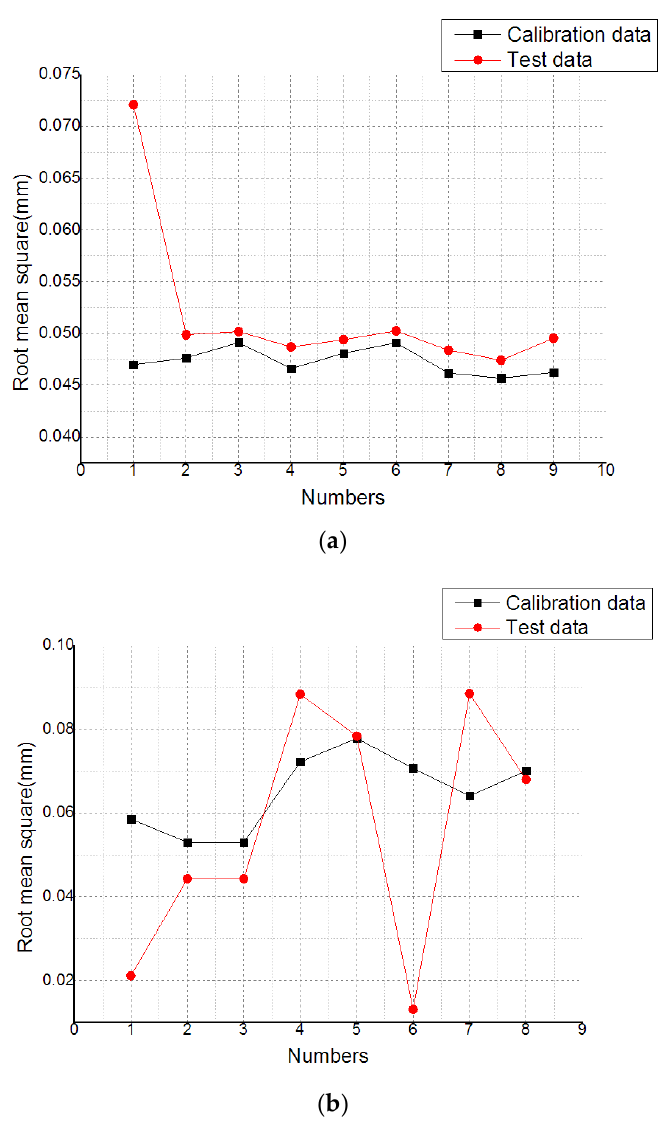
Figure 8. Analysis of different radial basis function interpolation and fitting accuracy with different shape parameters. ( a ) is the root mean square (RMS) calculated by using different shape parameters with different Multi-Quadric function (MQ function). ( b ) is the RMS calculated by using different shape parameters with different Gaussian function.